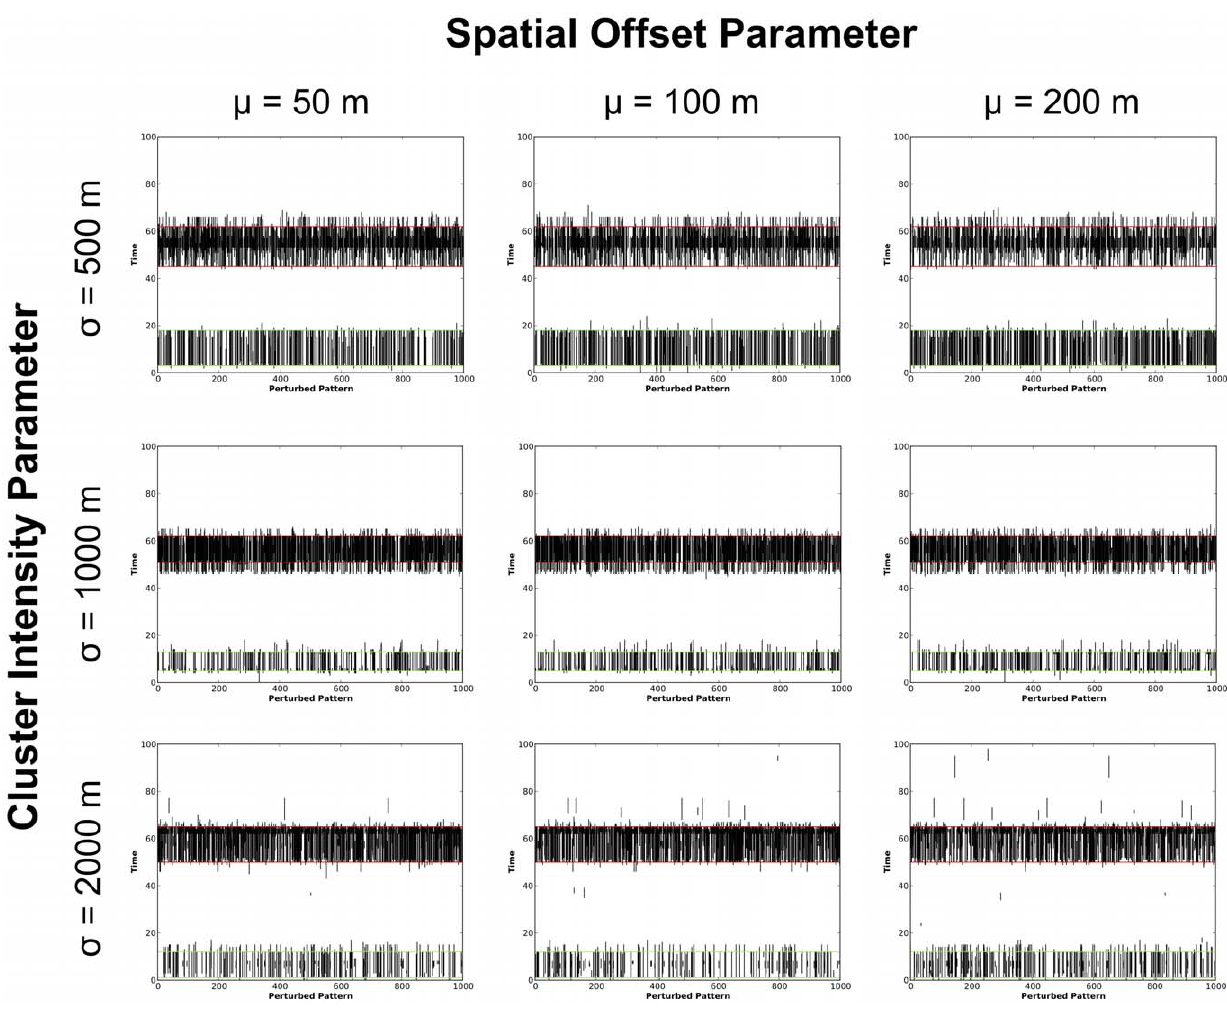
Figure 5. Plots of the duration of MLCs identified with the STPSS. The duration of the MLCs for the original datasets are denoted using horizontal red lines, secondary clusters are shown using green lines. MLCs from perturbed versions of the same dataset are shown as black vertical lines.